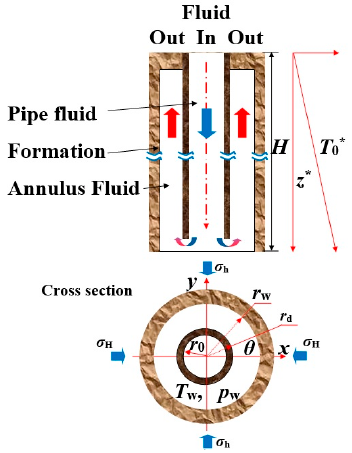
Figure 1. Fluid circulation W/R system.